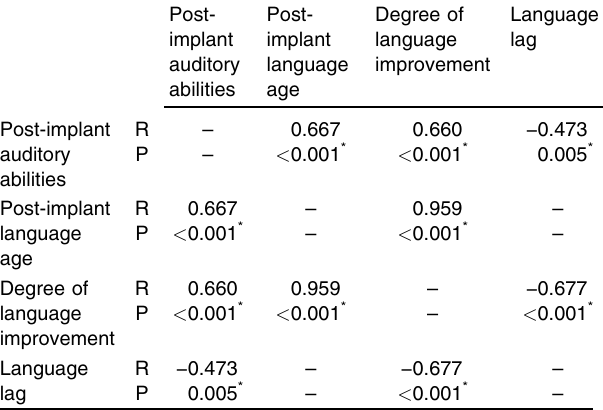
Table 7 Correlation between dependent